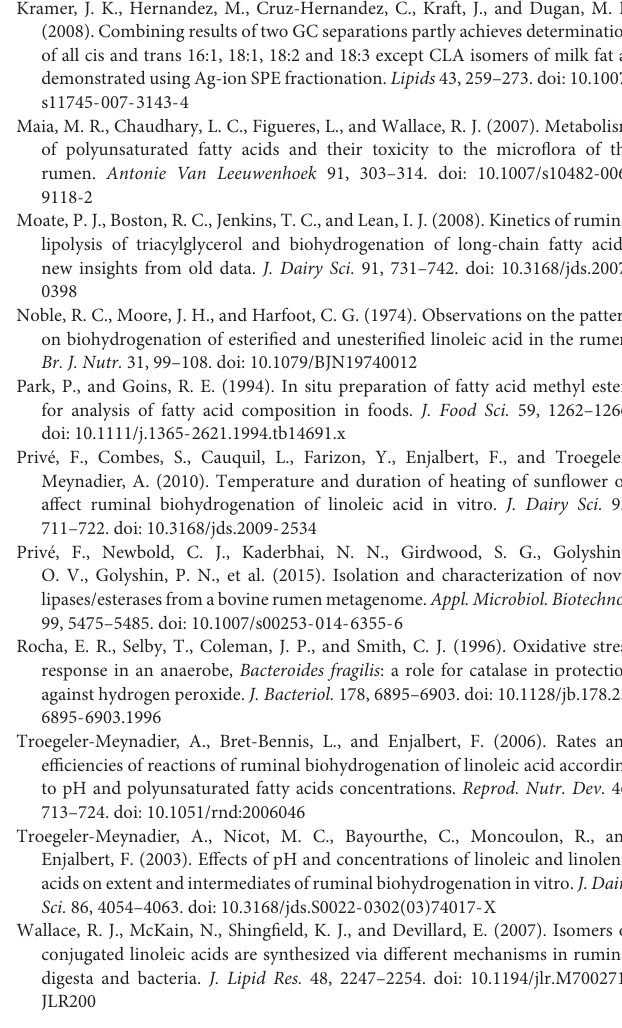
FIGURE S2 | Estimation of the total number of bacterial species by quantitative polymerase chain (qPCR, DNA copies/mL of culture) in 24 h ruminal cultures